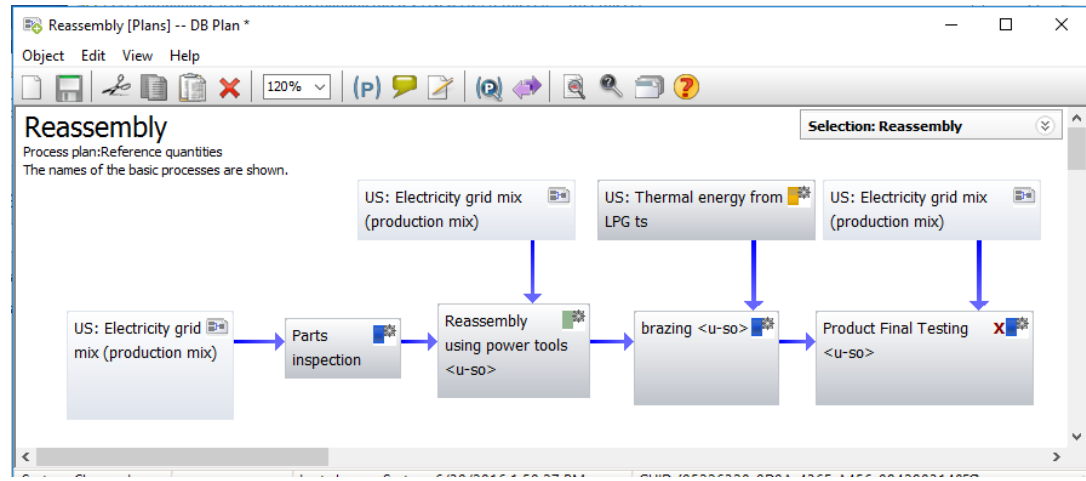
Figure 7. The reassembly phase model using GaBi software.